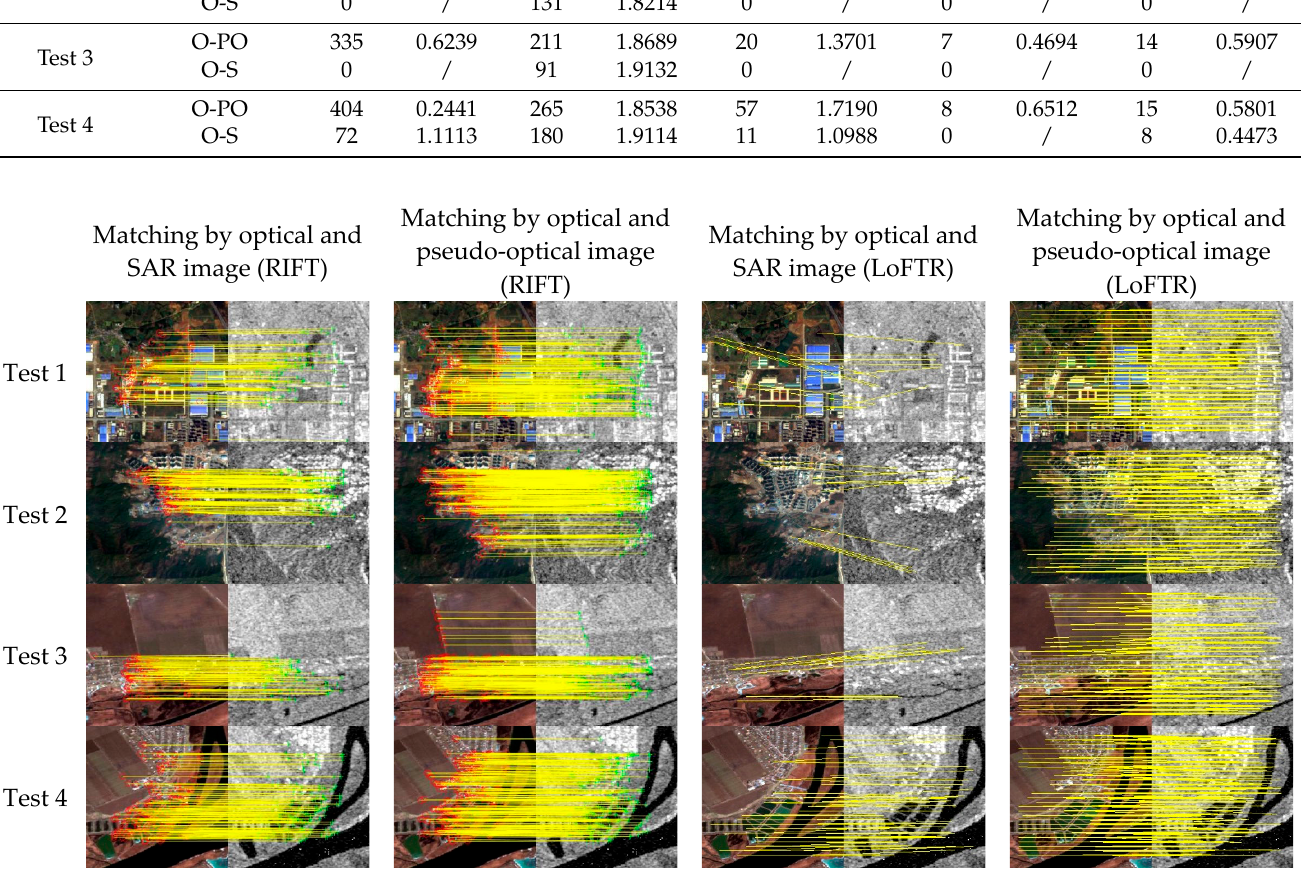
Figure 9. A visual comparison of the results of the matching experiment using RIFT and LoFTR.